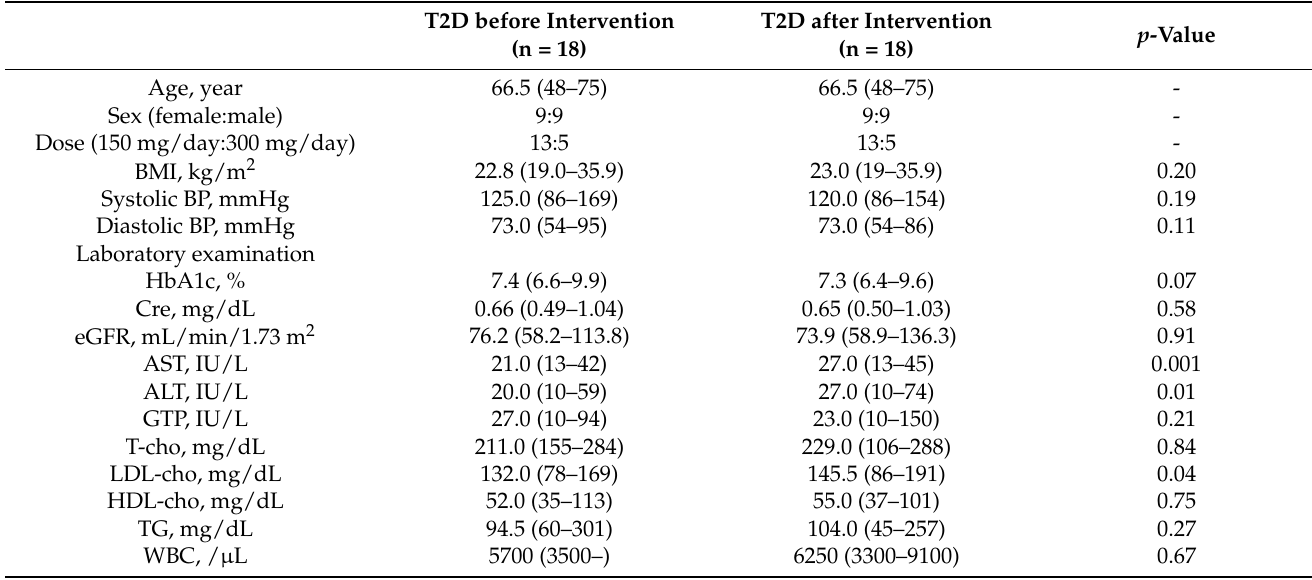
Table 1. Demographics and characteristics of the 18 patients with type 2